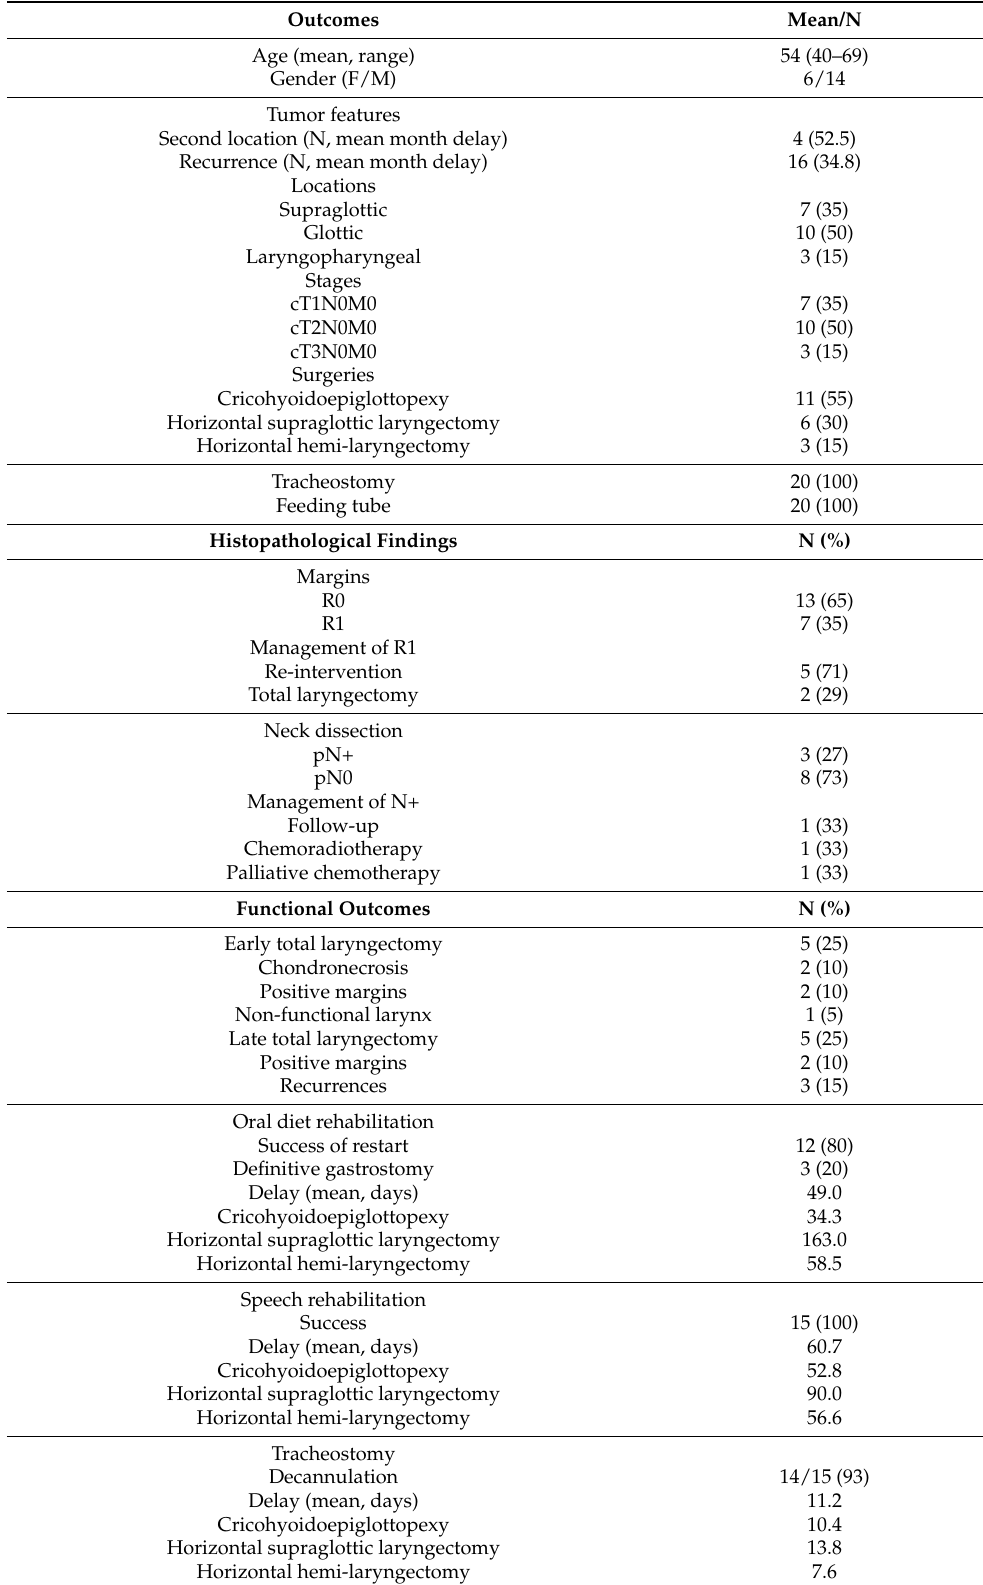
Table 1. Epidemiological, clinical and surgical